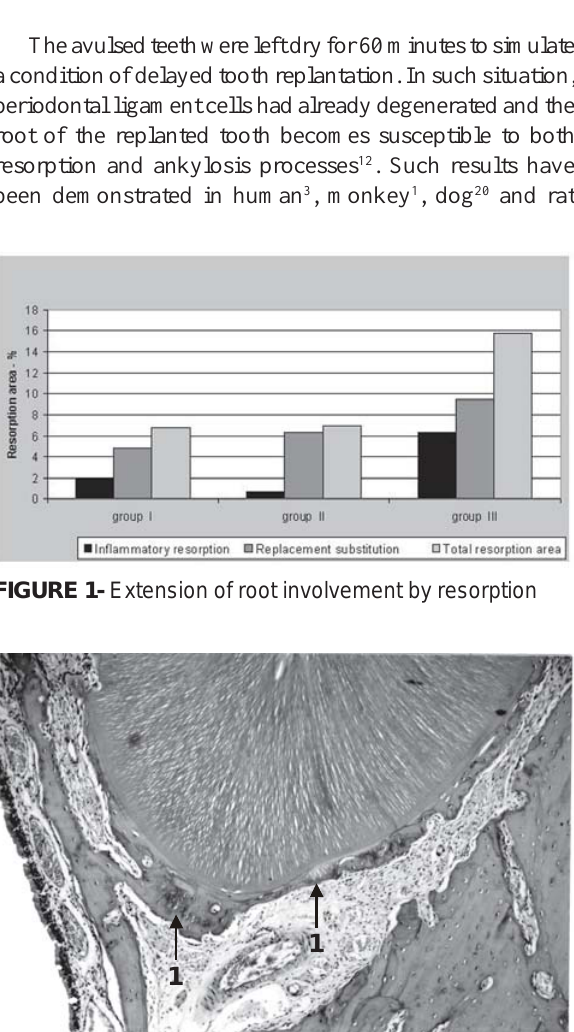
FIGURE 5- Group II. Bone tissue (BT) adjacent to an extensive area of healthy cementum. Notice the small areas of paralyzed surface resorption with bone tissue repair (1). Hematoxylin-eosin (original magnification